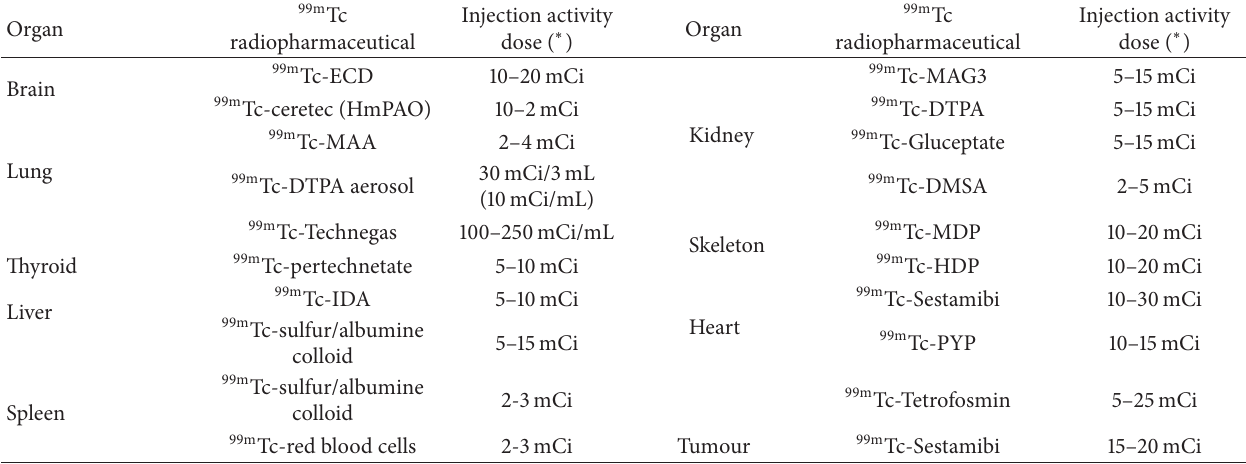
Table 1: Current application of 99m Tc for clinical SPECT imaging and activity dose requirement; ( ∗ ) The injection activity dose (mCi 99m Tc) normally delivered in 1mL solution of the 99m Tc-based radiopharmaceutical